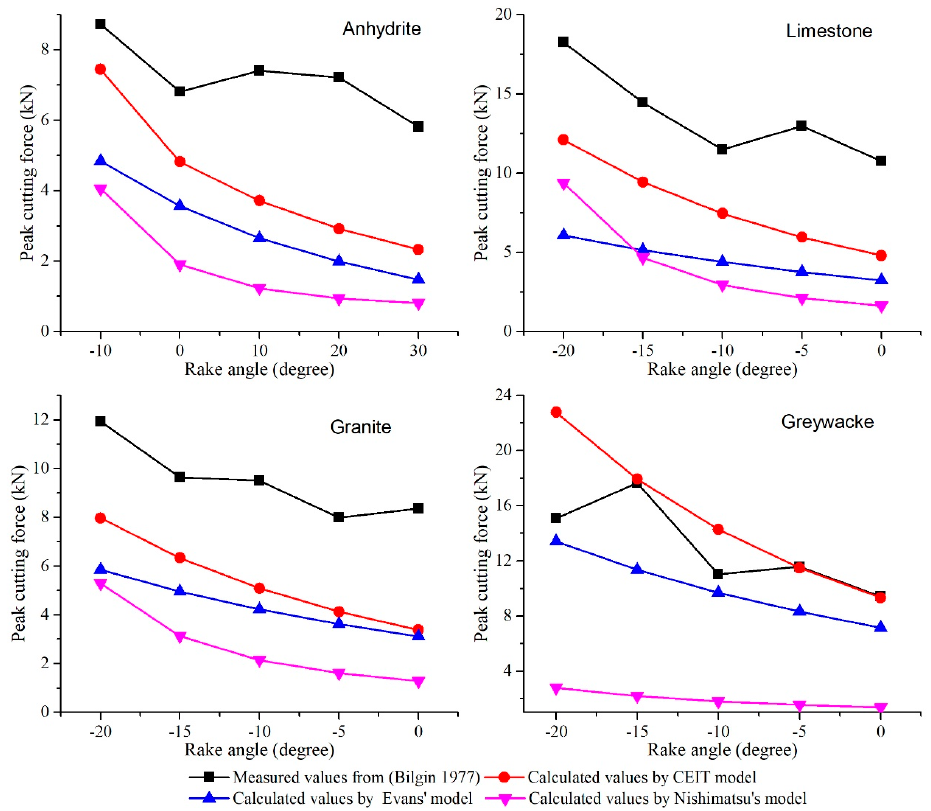
Figure 10. Comparison of the calculated and measured peak cutting forces at different rake angles.